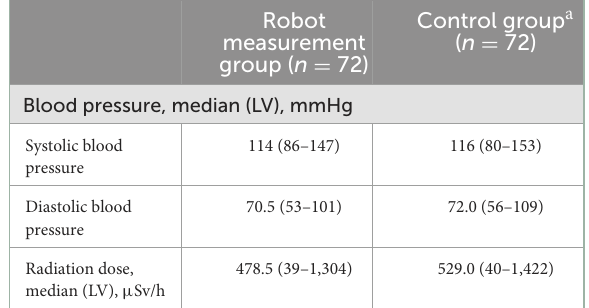
TABLE 1 Baseline demographics and clinical characteristics of all patients with radionuclide